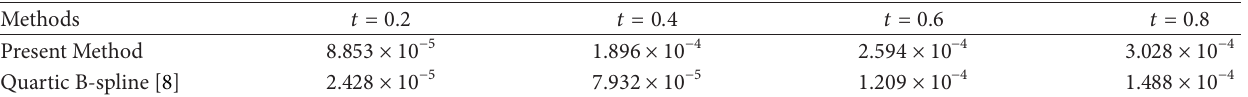
Table 8: The 𝐿 ∞ errors compared with quartic B-spline collection method at different times with 𝑑𝑥 = 0.005 , 𝑑𝑡 = 0.001 in [0,1] and IMQ RBF ( 𝑐 = 0.05 ).